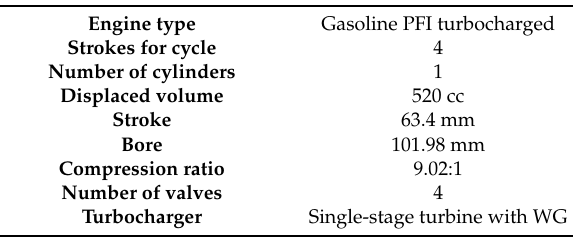
Table 1. Engine main features.